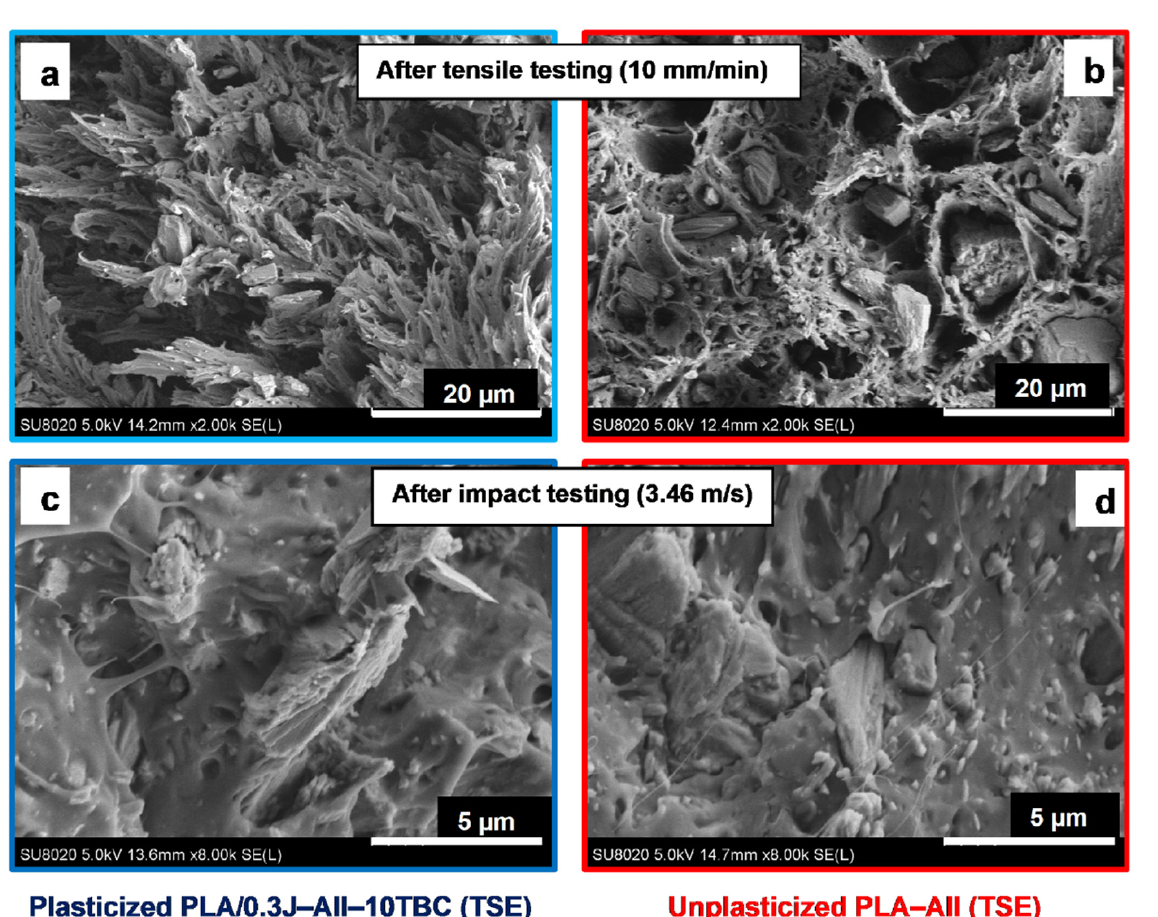
Figure 14. ( a – d ) SEM images (SE mode) of PLA–AII composites (with/without plasticizer) per- formed on the fractured surfaces obtained after ( a , b ) tensile and ( c , d ) impact